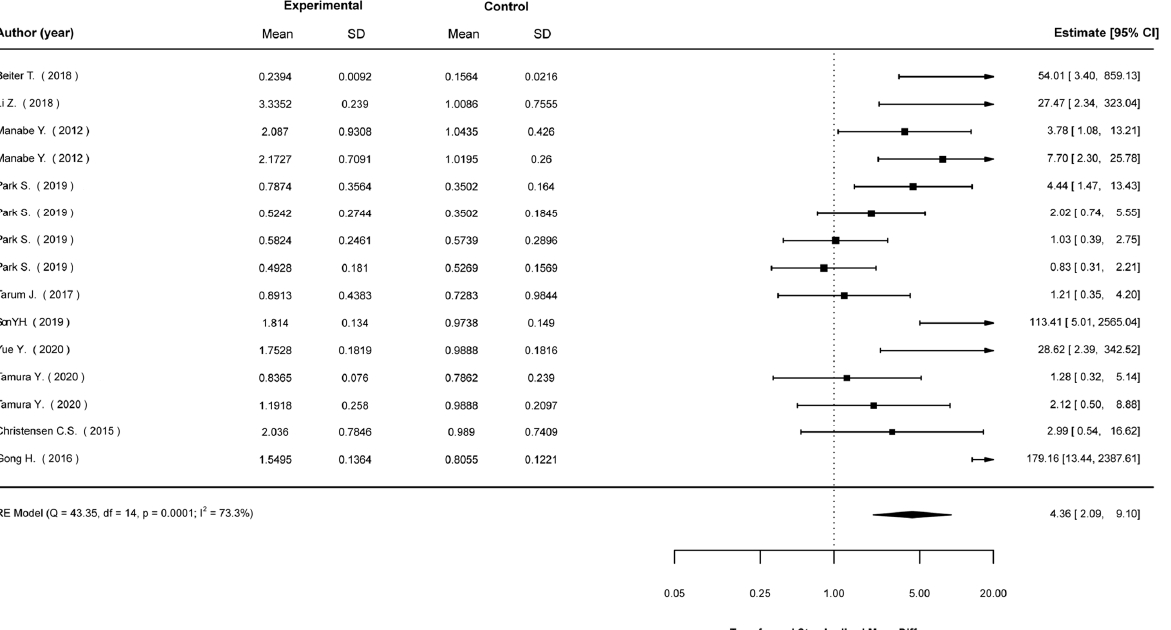
Figure 2. Findings of random-effects meta-analysis on the effects of EPS on Akt compared to non- stimulated cells. Results shown are transformed standardized mean differences and 95% confidence intervals, as an estimate of the log odds ratio. Differences greater than 1.00 favour the EPS cells compared to non-stimulated control cells [16,19,20,24,28,48,53,55].